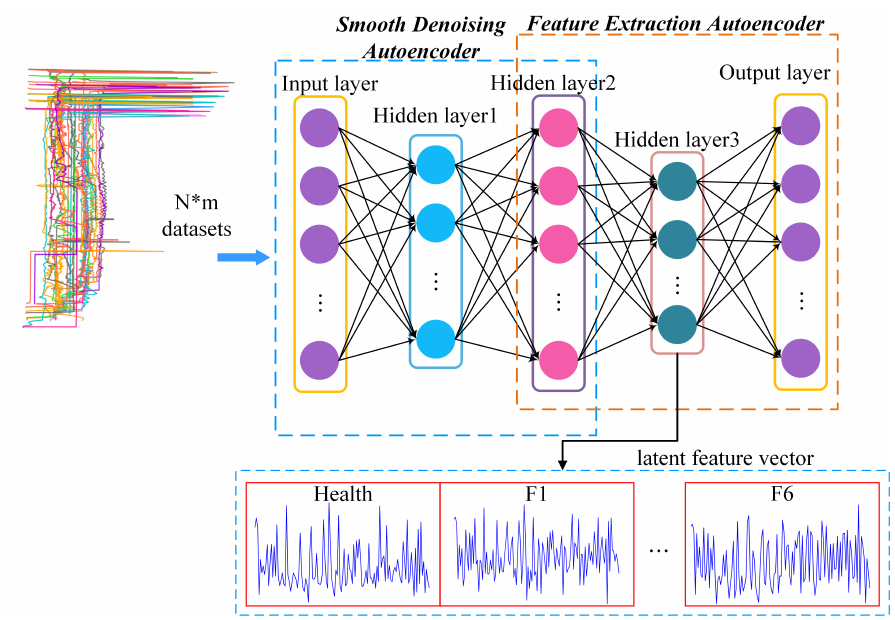
Figure 4. Frame diagram of the autoencoder combined with smooth denoising and feature